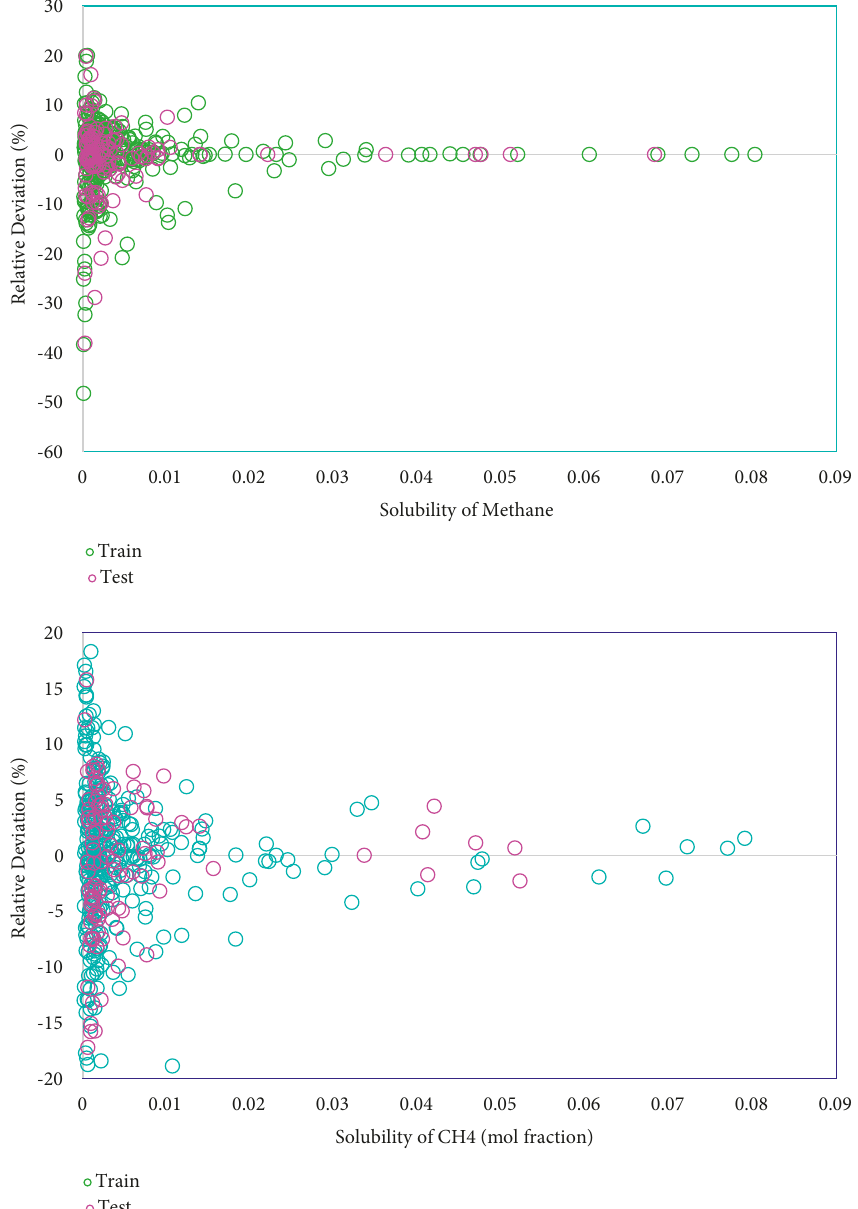
Figure 6: Relative deviation between the predicted and experimental methane solubility values for (a) ANFIS (b)